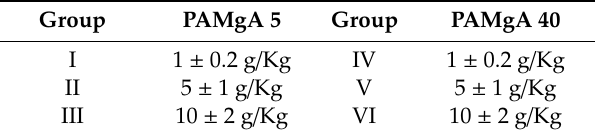
Table 1. Experimental groups for the oral biocompatibility